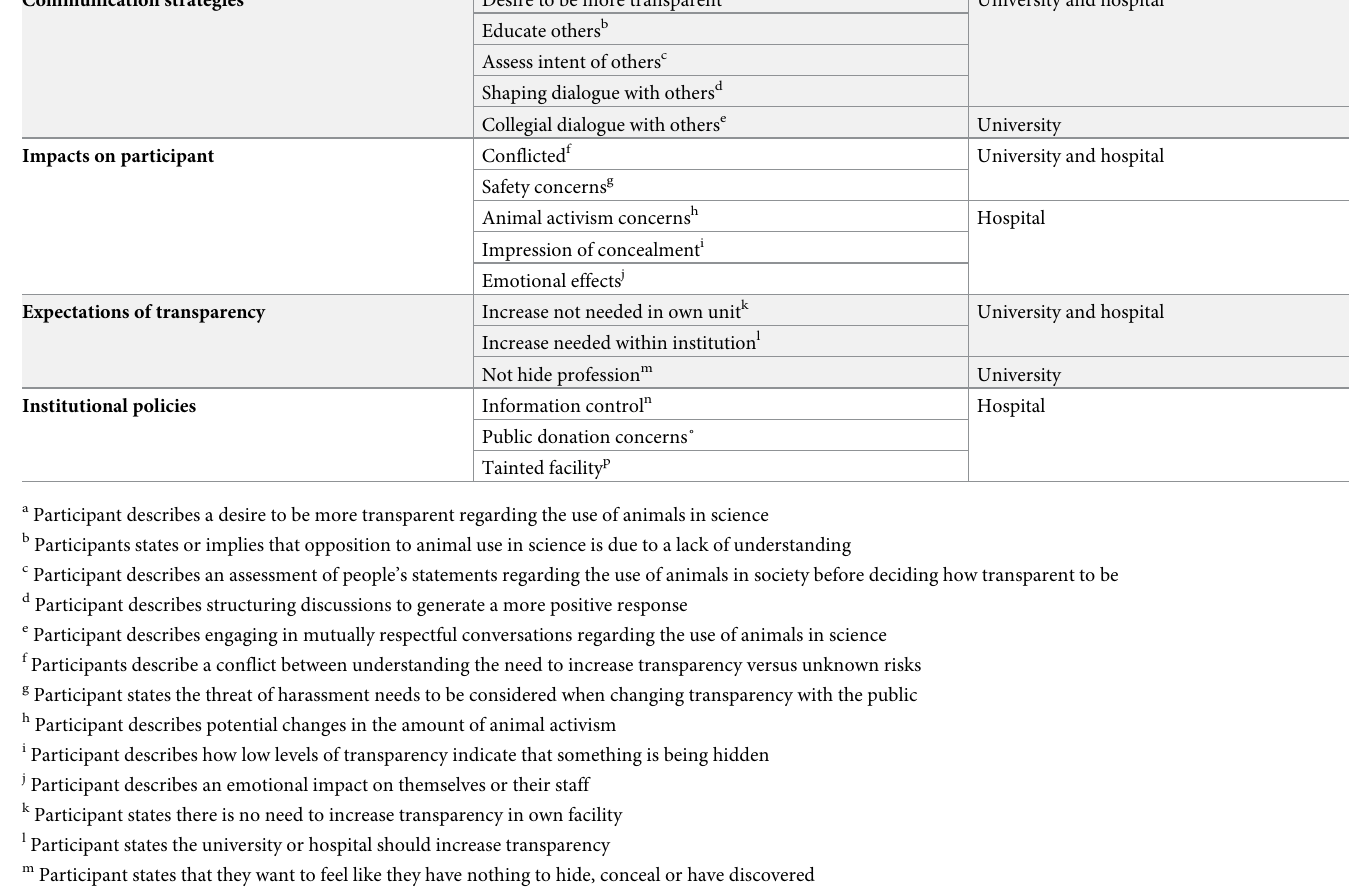
Table 1. Perceptions of transparency themes and subthemes from 12 interviews of animal facility managers working at either university or hospital campuses within one animal care and use program.